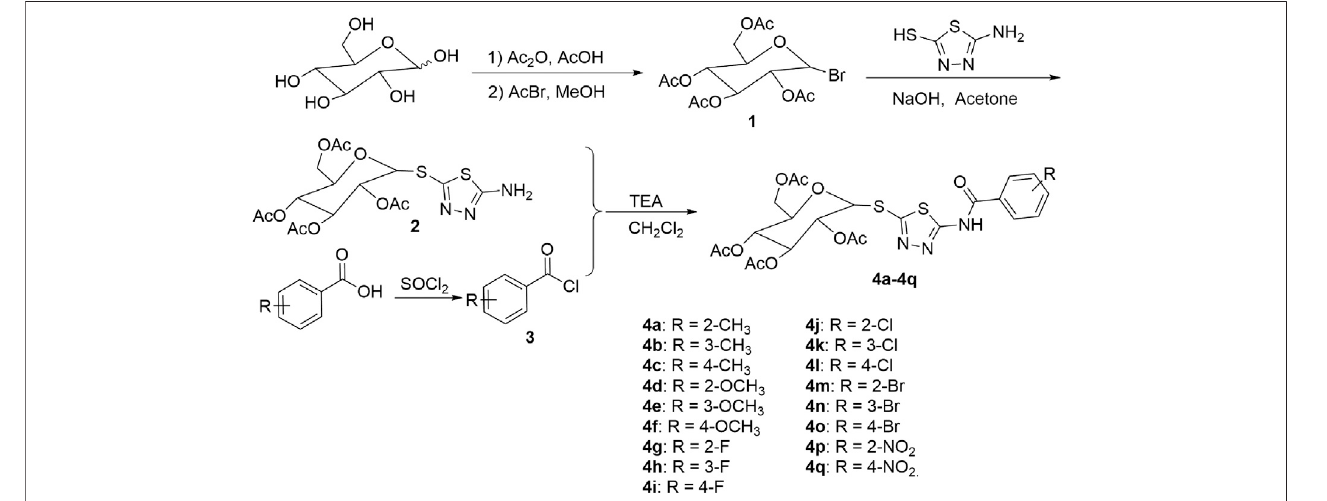
FIGURE 1 | Synthetic route of the target compounds 4a – 4q